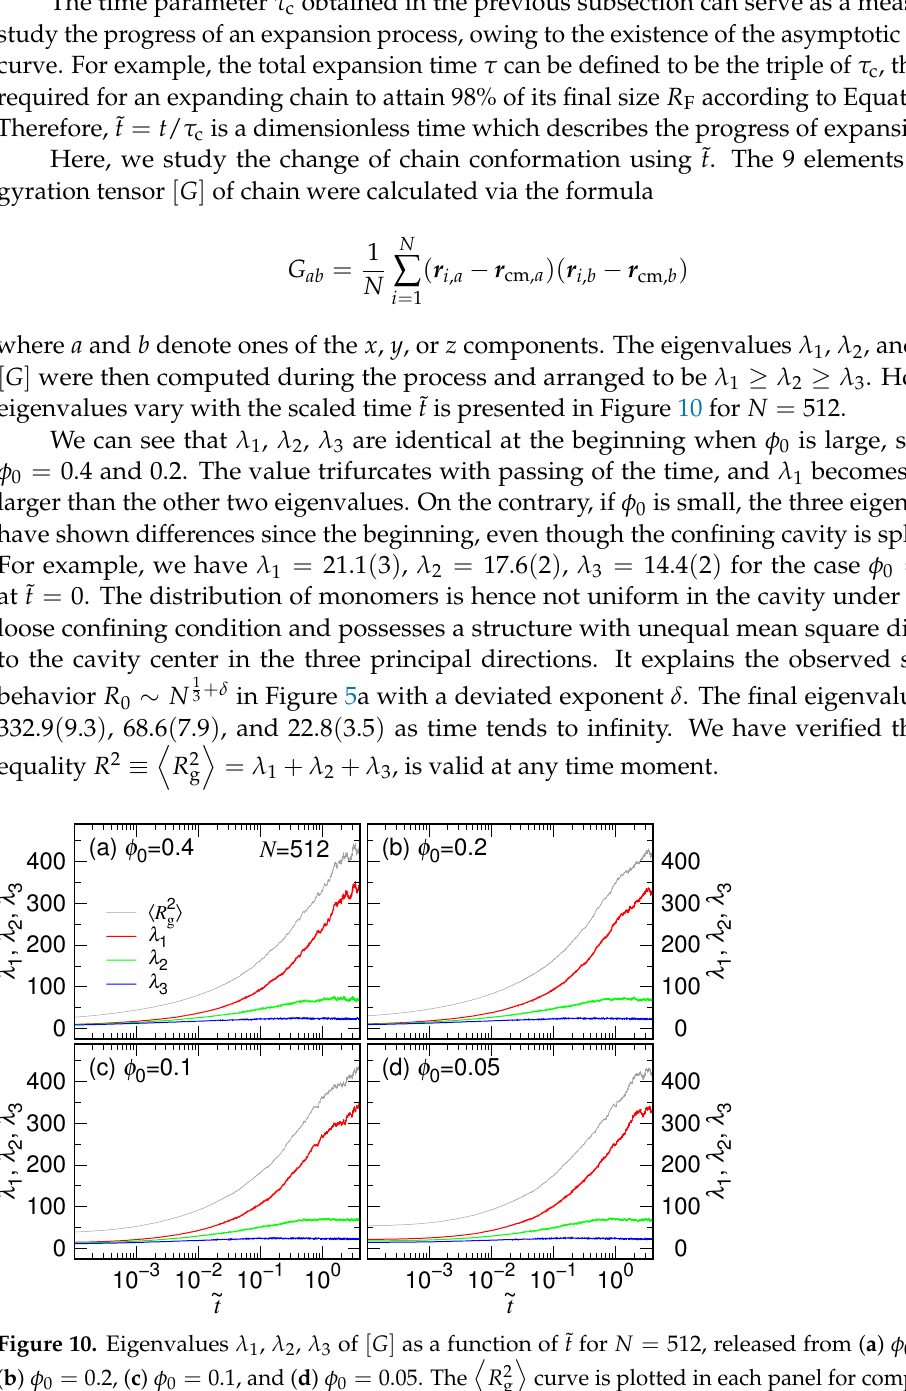
(cid:68) (cid:69) R 2 g curve is plotted in each panel for comparison.